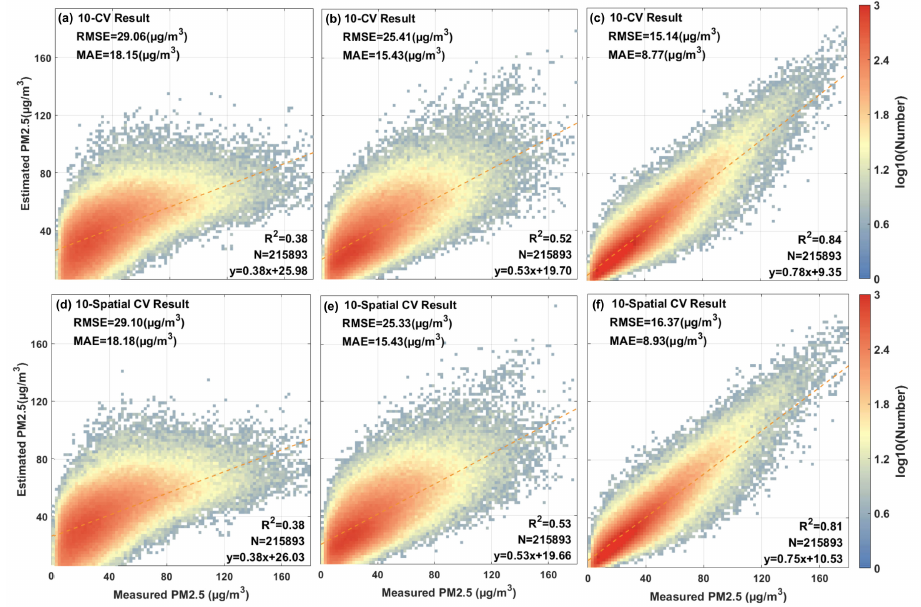
Figure 6. Scatterplot of the sample-based ( a – c ) and station-based ( d – f ) CV for surface PM 2.5 estima- tions from the different models: ( a , d ) MLR, ( b , e ) LME, and ( c , f ) STBT model. Surface PM 2.5 concentrations measured by sites and estimated by the STBT model are plotted in Figure 7. The bias between estimations and measurements from during the study period (from 1 January to 31 December 2018) is plotted in the same figure. The annual average bias between the estimated and measured PM 2.5 concentration is 7.16 µ g/m 3 . The estimated results match the measured values well, especially in